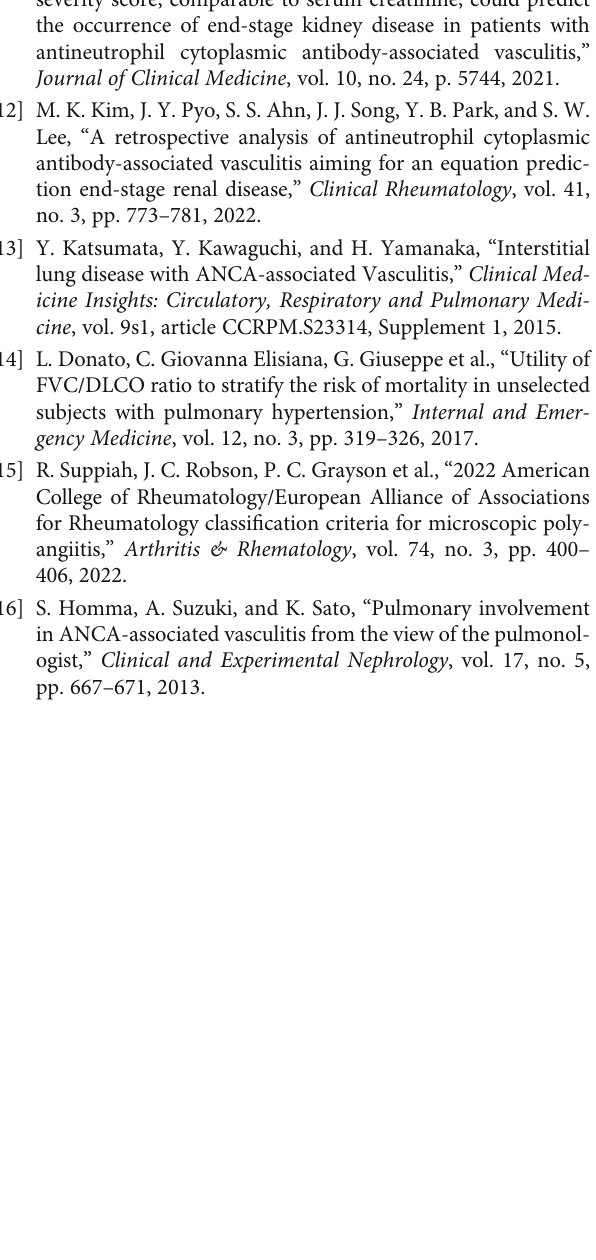
Supplementary 1 . Supplementary Table 1: comparison of ILD ∗ patterns among three AAV subtypes in AAV patients ( N = 255 ). Supplementary 2 . Supplementary Table 2: comparison of ILD ∗ patterns according to ANCA type in AAV patients ( N = 255 ). Supplementary 3 . Supplementary Table 3: comparison of pulmonary function tests according to ILD ∗ patterns in AAV patients with ILD ( N = 26 ). Supplementary 4 . Supplementary Fig. 1: comparison of cumulative patients ’ survival rates in AAV patients